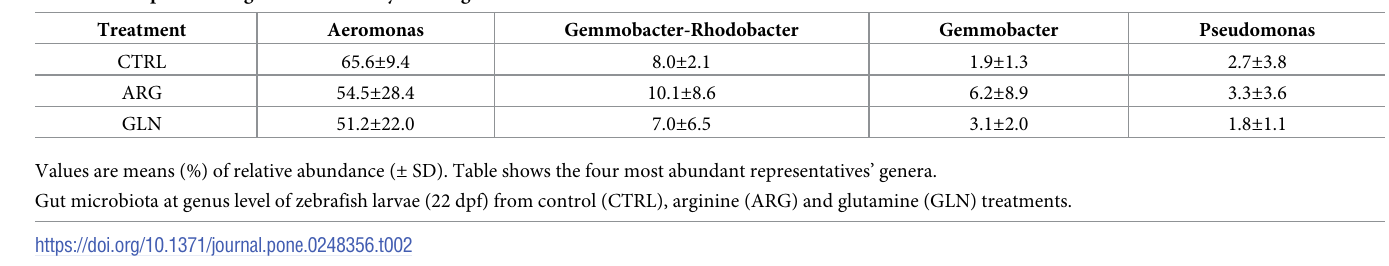
Table 2. Composition of gut bacterial ecosystem at genus level.